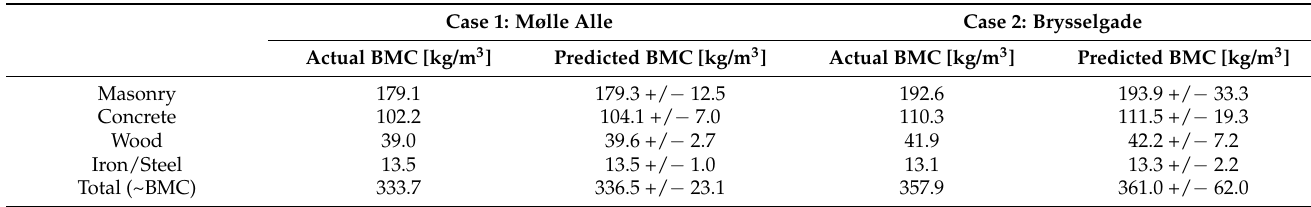
Table 5. Building material composition for two cases, actual vs.